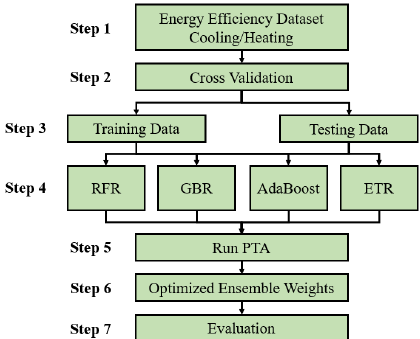
Figure 8. PTA Methodology for Ensemble Weight Optimization for Energy Efficiency Estimation.